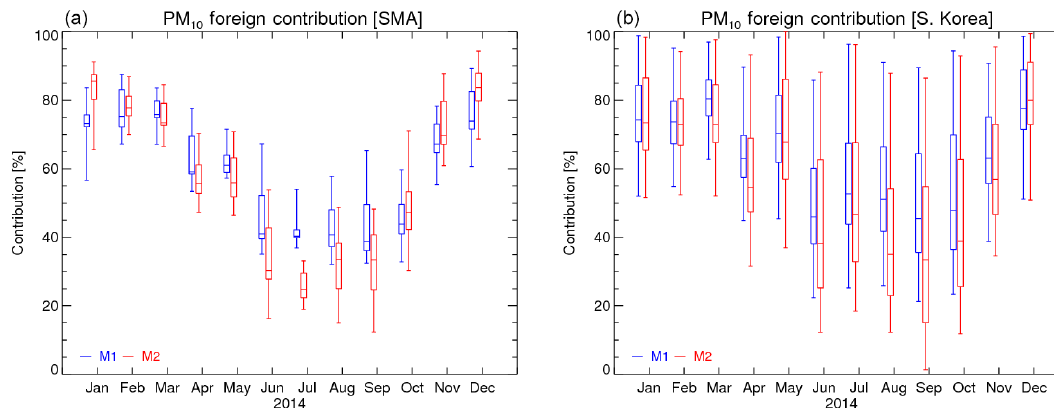
Figure 6. Seasonal variation in foreign emissions contributions to the SMA (a) and to South Korea (b) .